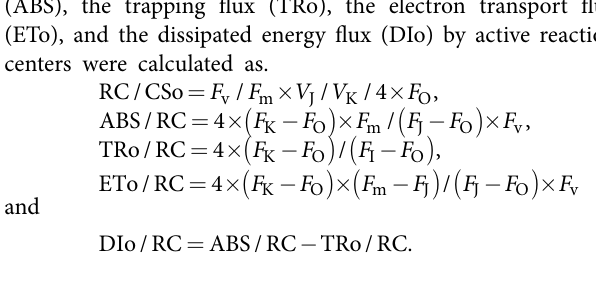
TABLE 1 | Measured and calculated parameters used in this